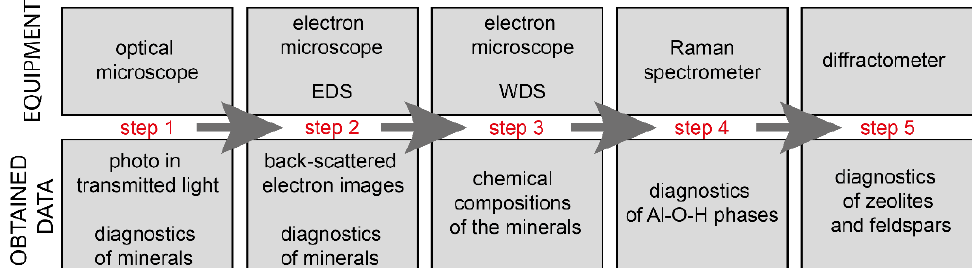
5 of 22 Table 2. List of studied samples. Sampling Point